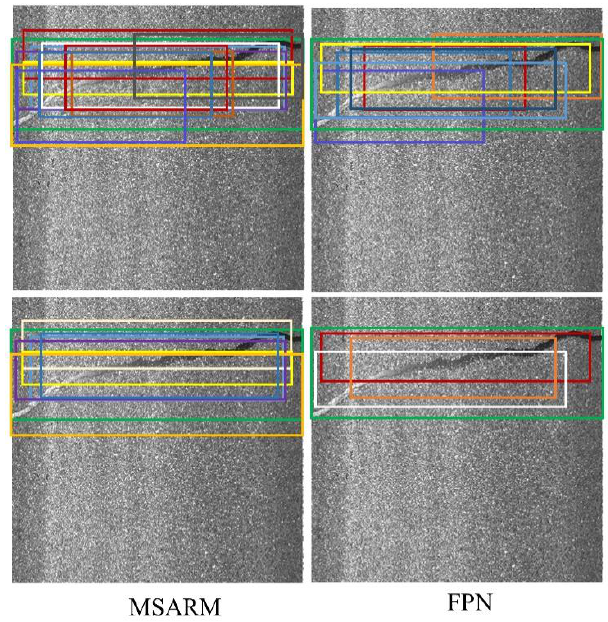
Figure 8. Anchors generated by two anchor mechanisms. Green bounding box indicates ground truth, and other colors indicate generated anchors. Rows 1 and 2 represent anchors matching ground truths with the two mechanisms when IOU is 0.5 and 0.7, respectively.